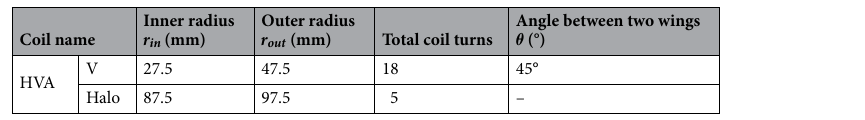
Table 1. Design parameters of HVA coil.